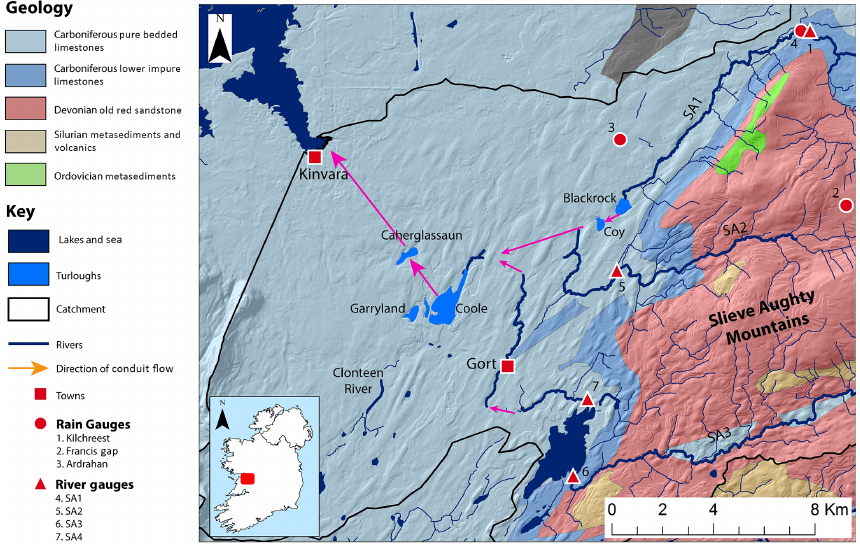
Figure 1. Geology of study area displaying turloughs, rain gauges, Kinvara, river gauging stations, the direction of underground conduit flow and the Kinvara springs catchment.